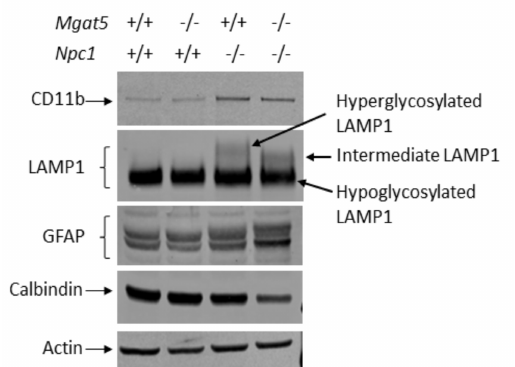
Figure 3. Western blot analysis of 6-week-old cerebellar extracts of mutant mice. Soluble cerebellar protein extracts (40 µ g) were analyzed for CD11b (microglia marker), GFAP (astrocyte marker), calbindin (Purkinje neuron marker), and LAMP1 (lysosome marker). In addition to the domi- nant ~75 kDa hypoglycosylated LAMP1 form present in the cerebellum, hyperglycosylated LAMP1 appears in Mgat5 +/+ :Npc1 − / − mice. In Mgat5 − / − :Npc1 − / − mice, the hyperglycosylated form of LAMP1 is smaller, giving rise to an intermediate form of LAMP1 lacking complex N-glycosylation. In Mgat5 − / − :Npc1 − / − mice, GFAP appears increased and calbindin appears decreased relative to Mgat5 +/+ :Npc1 − / − mice, indicative of increased astrogliosis and/or increased Purkinje neuron loss in the double mutant mice. Actin was used as a protein load control. Representative blot of two mice from each genotype.